Question: Express in one sentence what the figure is showing.
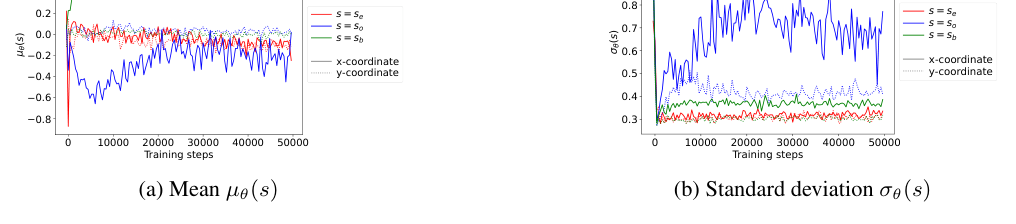
Answer: Trends of x and y coordinates for the mean and standard deviation of the parameterized initial distribution for some critical states, during training.